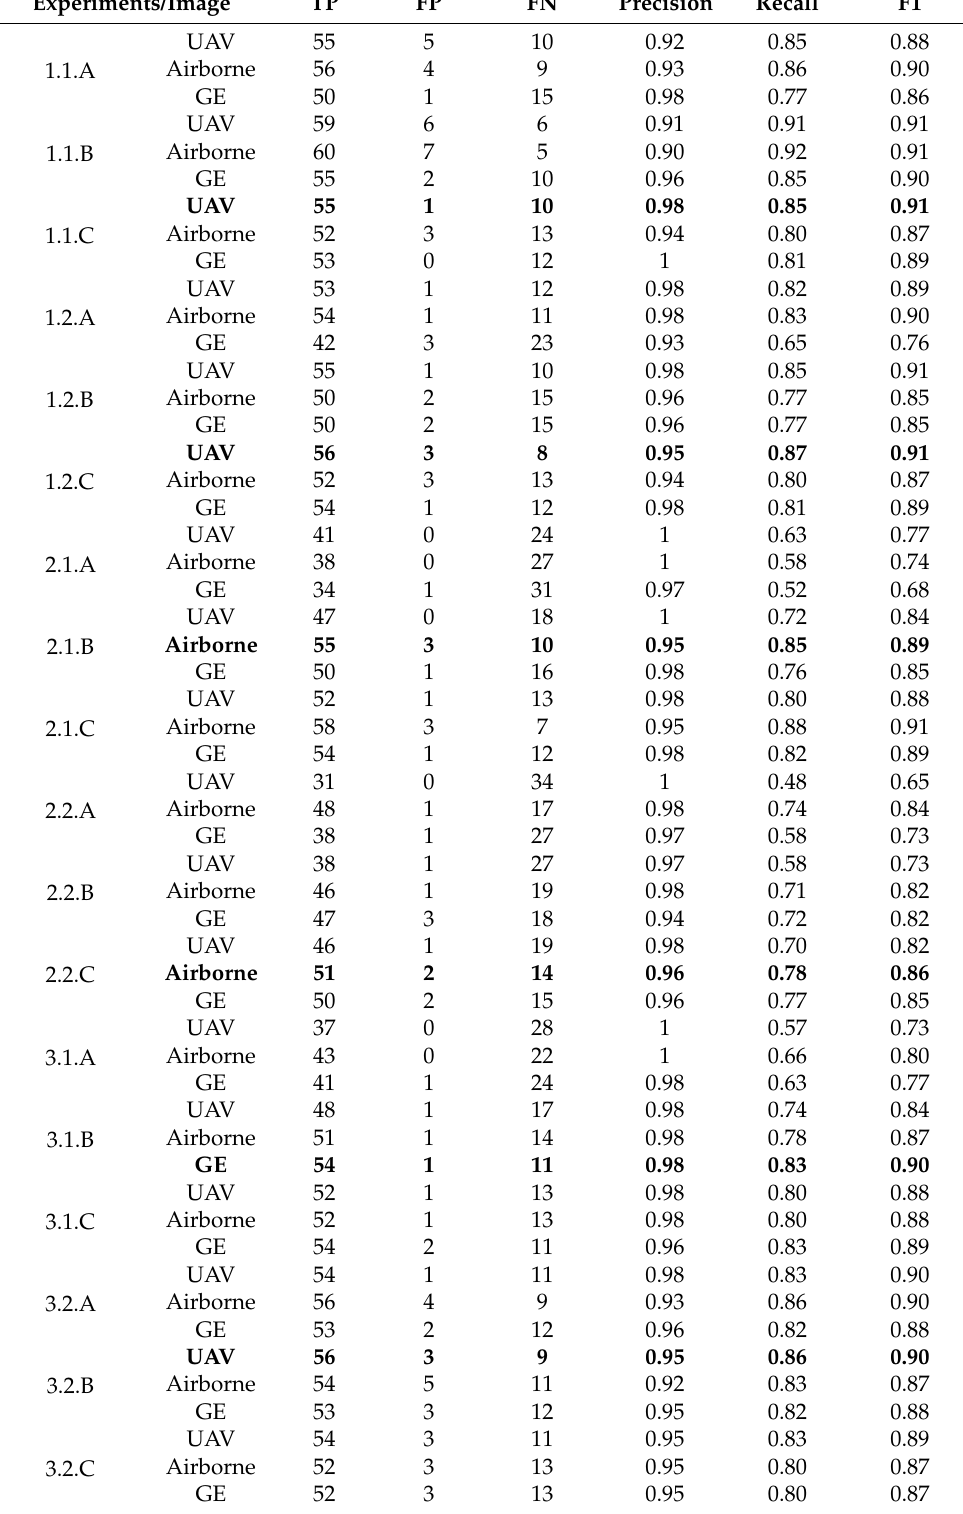
Table 2. Test results of Mask Region-based Convolutional Neural Networks (Mask R-CNN) ex- periments in three different spatial resolutions images. TP: True Positive; FP: False Negative; FN: False Negative. Precision, Recall, and F1-measure were used for detection results. In bold the most accurate